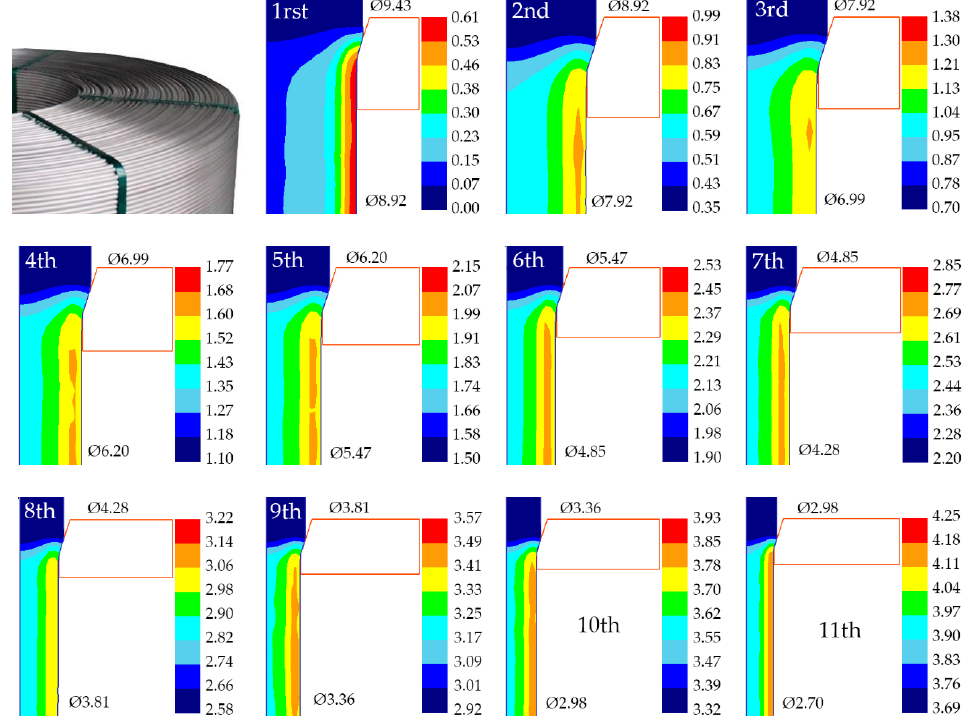
ff ective strain ( ε Figure 10. Effective strain ( ε eff . ) distribution in the section of the wire, for each of the wiredrawing stages. Figure 10. E e ff . ) distribution in the section of the wire, for each of the wiredrawing